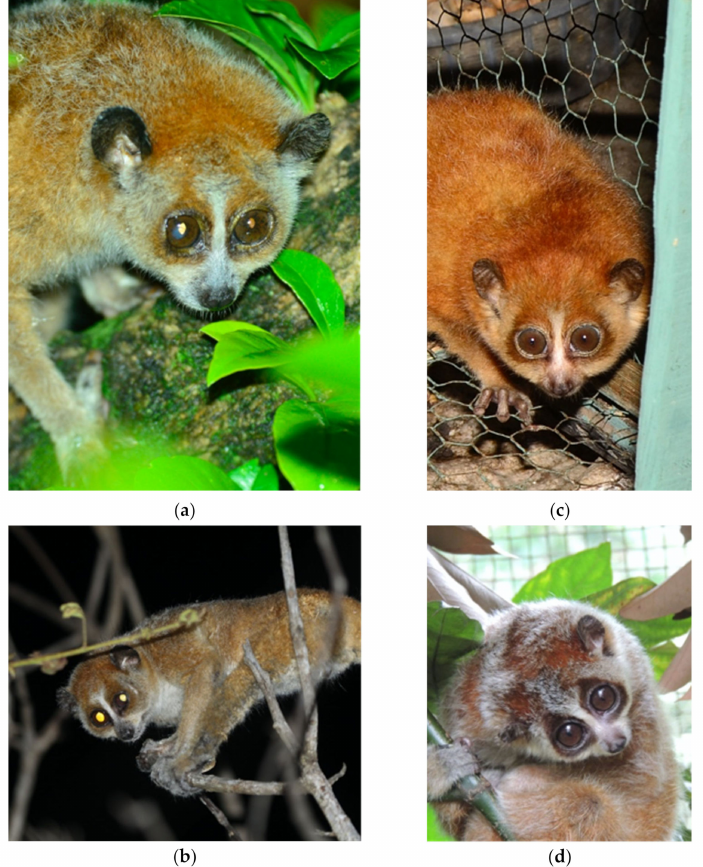
Figure 7. Photos depicting the longer muzzle in the southern pygmy loris: ( a ) Lam Dong Province, Vietnam in 2015, Photo by H. Thach; ( b ) Bu Gia Map National Park, Binh Phuoc Province, Vietnam in 2014, Photo by Kieu Dinh Th á p); and a shorter muzzle in the northern pygmy loris: ( c ) Tuyen Quang Province, Vietnam in 2013; Photo by H. Thach; ( d ) EPRC, Cuc Phuong National Park, Vietnam in 2014, Courtesy of T. Nadler, Photo by M. Blair) also showing the full range seasonal pelage change in the pygmy loris: ( c ) summer coloring; ( d ) winter